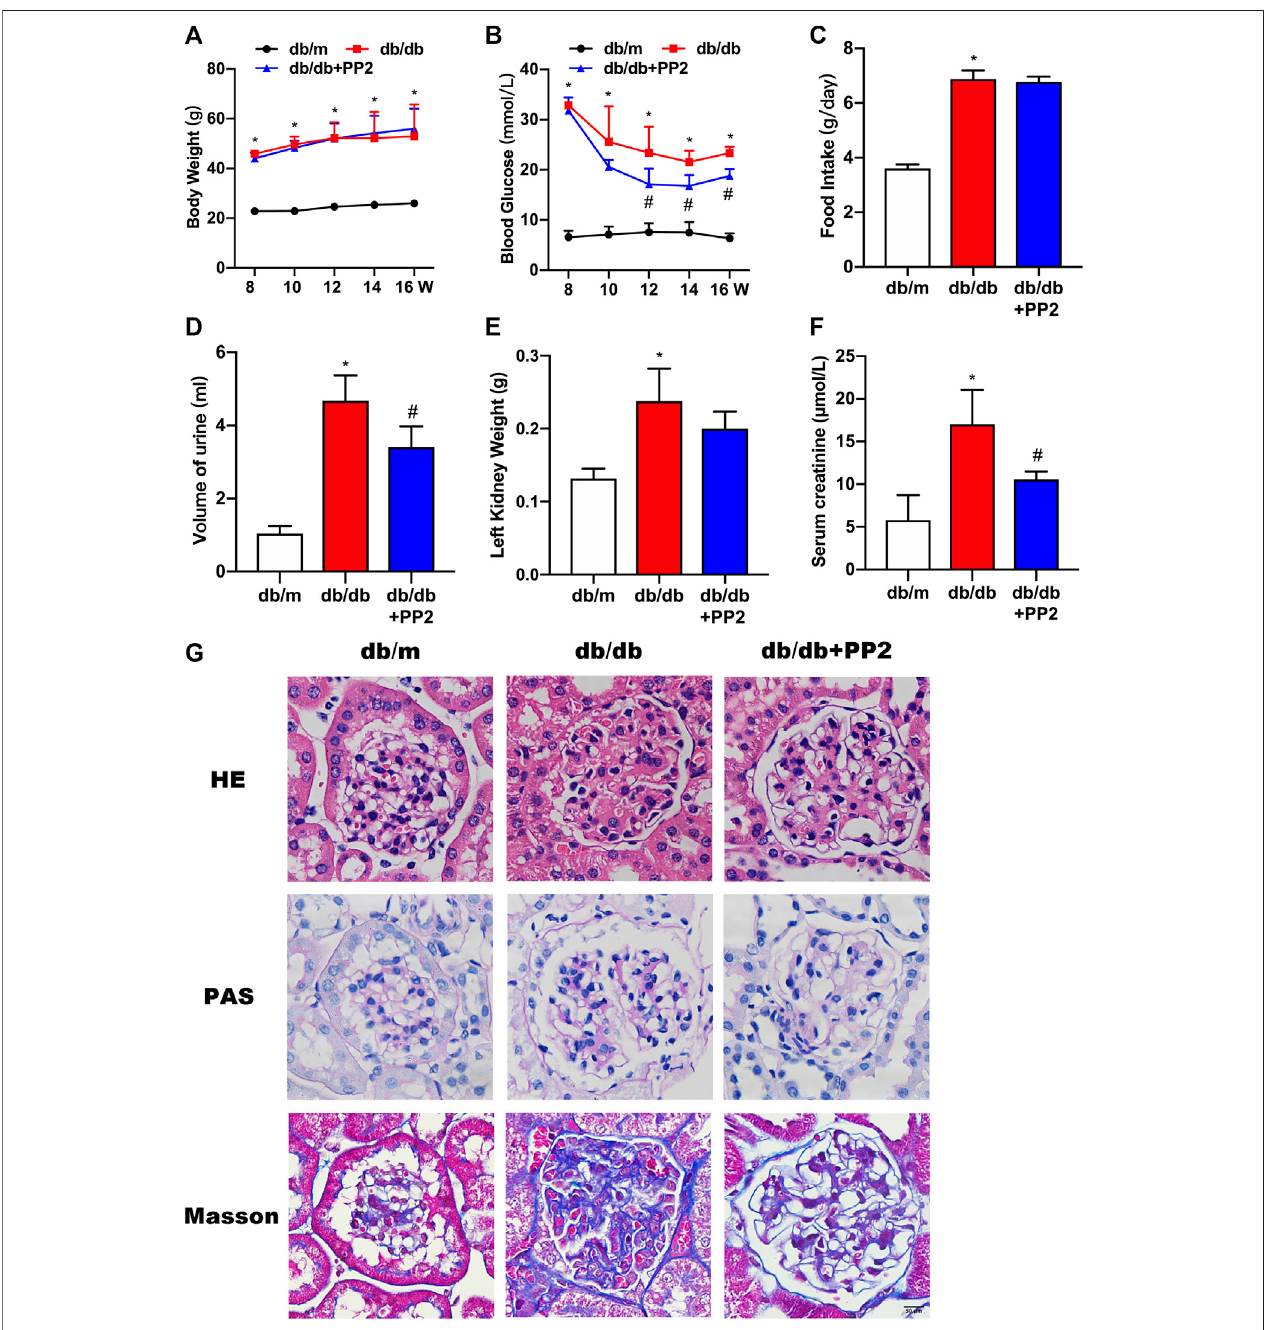
FIGURE 1 | Effects of the Src inhibitor PP2 on the biochemical and histopathological characteristics of db/db mice. (A) Body weight changes in the control (db/m) mice, diabetic (db/db) miceand PP2-treated db/db mice from 8 to 16 weeks ofage. (B) Blood glucose levels in each group. (C) Food intake. (D) Urine volumes in 24 h. (E) Left kidney weights. (F) Serum creatinine levels. (G) HE, PAS and Masson ’ s staining were used to evaluate the histological changes and glomerulus damage in each treatment group (Magni fi cation, 400 ×). Values are expressed as the mean ± SD, * p < 0.05 vs. db/m group; # p < 0.05 vs. db/db group. n = 5.